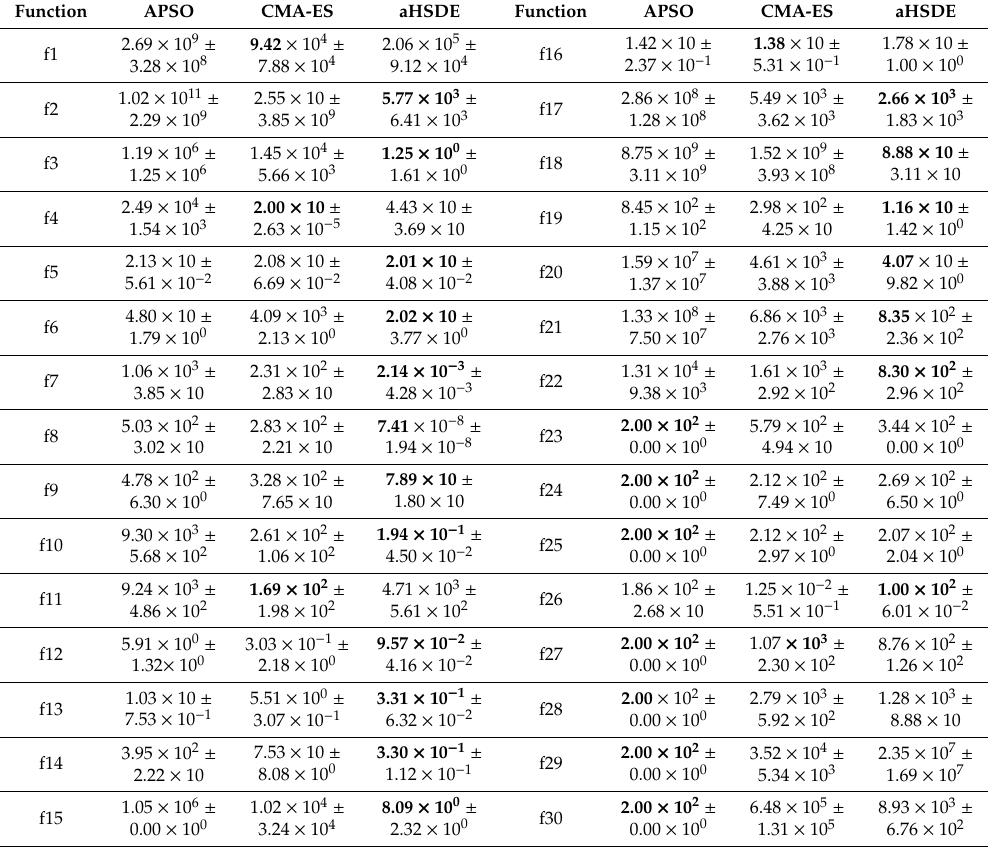
Table 3. Comparison on mean best and standard deviation of multiple runs of Adaptive Particle Swarm Optimization (APSO), Evolution Strategy with Covariance Matrix Adaptation (CMA-ES) and the aHSDE based on IEEE CEC 2014